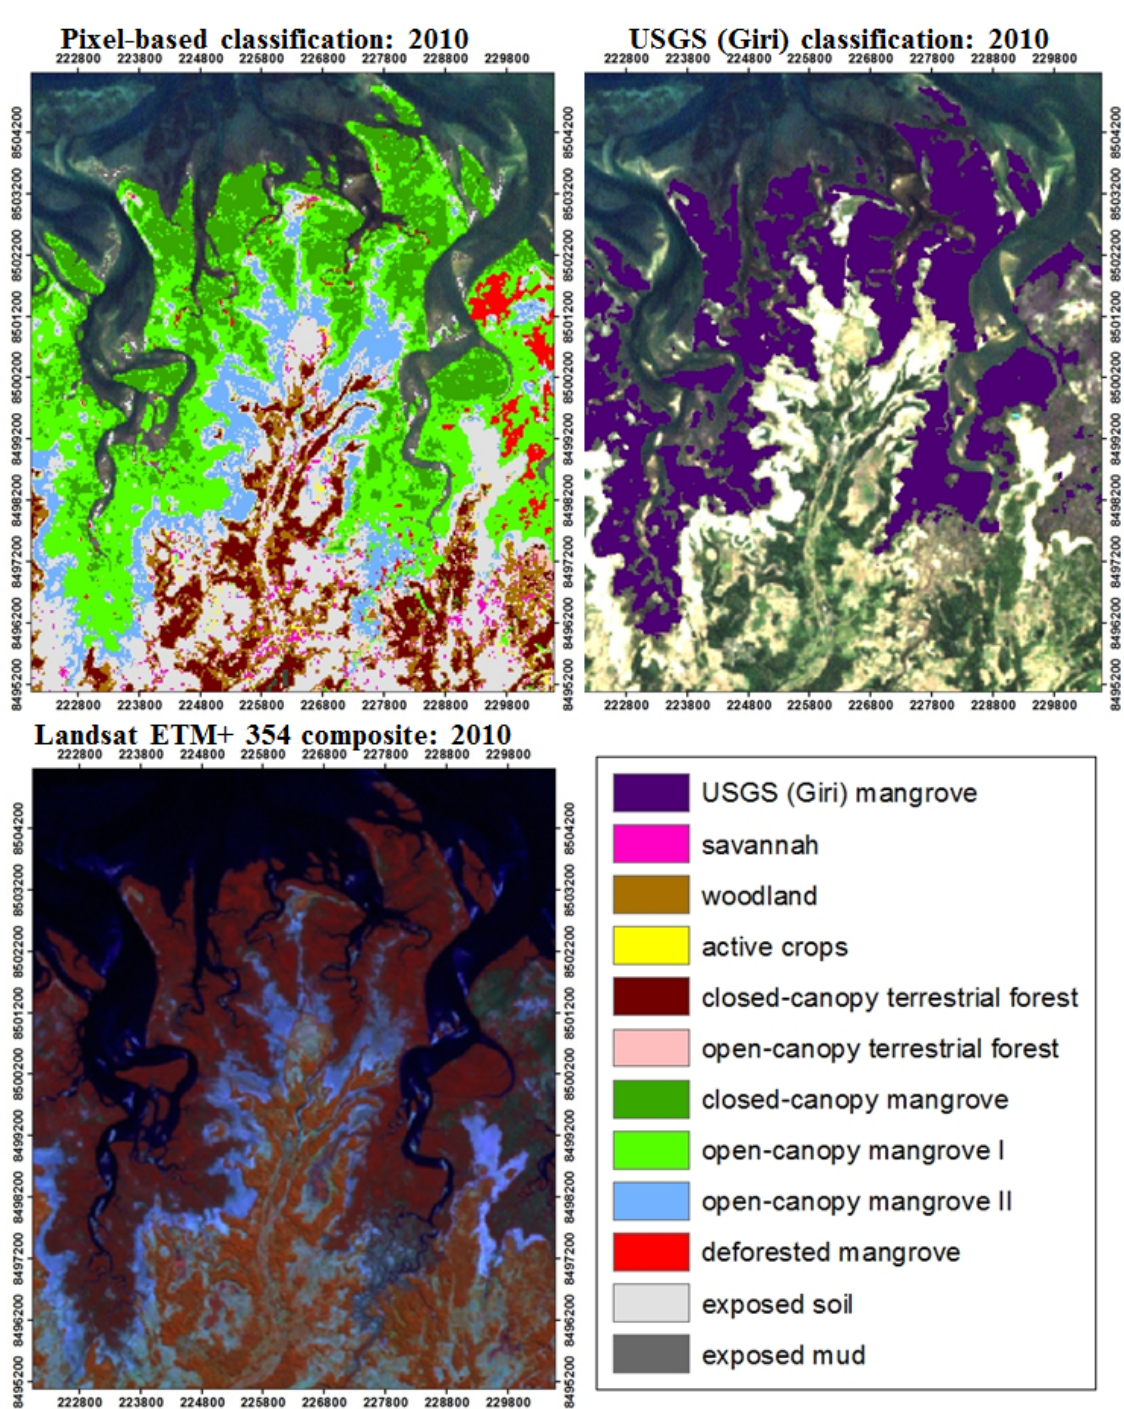
Figure 5. Comparison between GLS 2010 Landsat classification results ( top left ) and single-class USGS 2010 mangrove coverage ( top right ) for a sub-set of the area of interest (AOI). A Landsat Enhanced Thematic Mapper (ETM+) color composite, where band 3 is blue, band 5 is green and band 4 is red, is shown for context ( bottom left